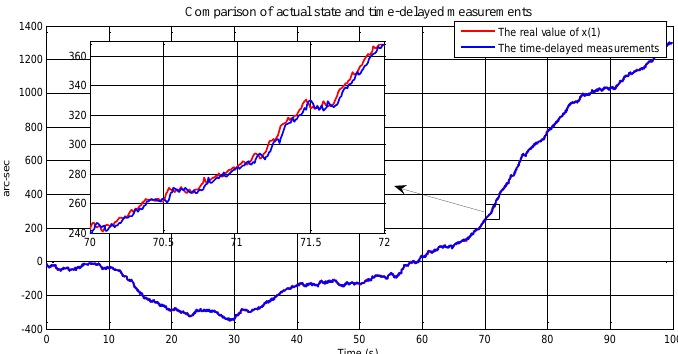
Figure 1. Actual state and time-delayed measurements.